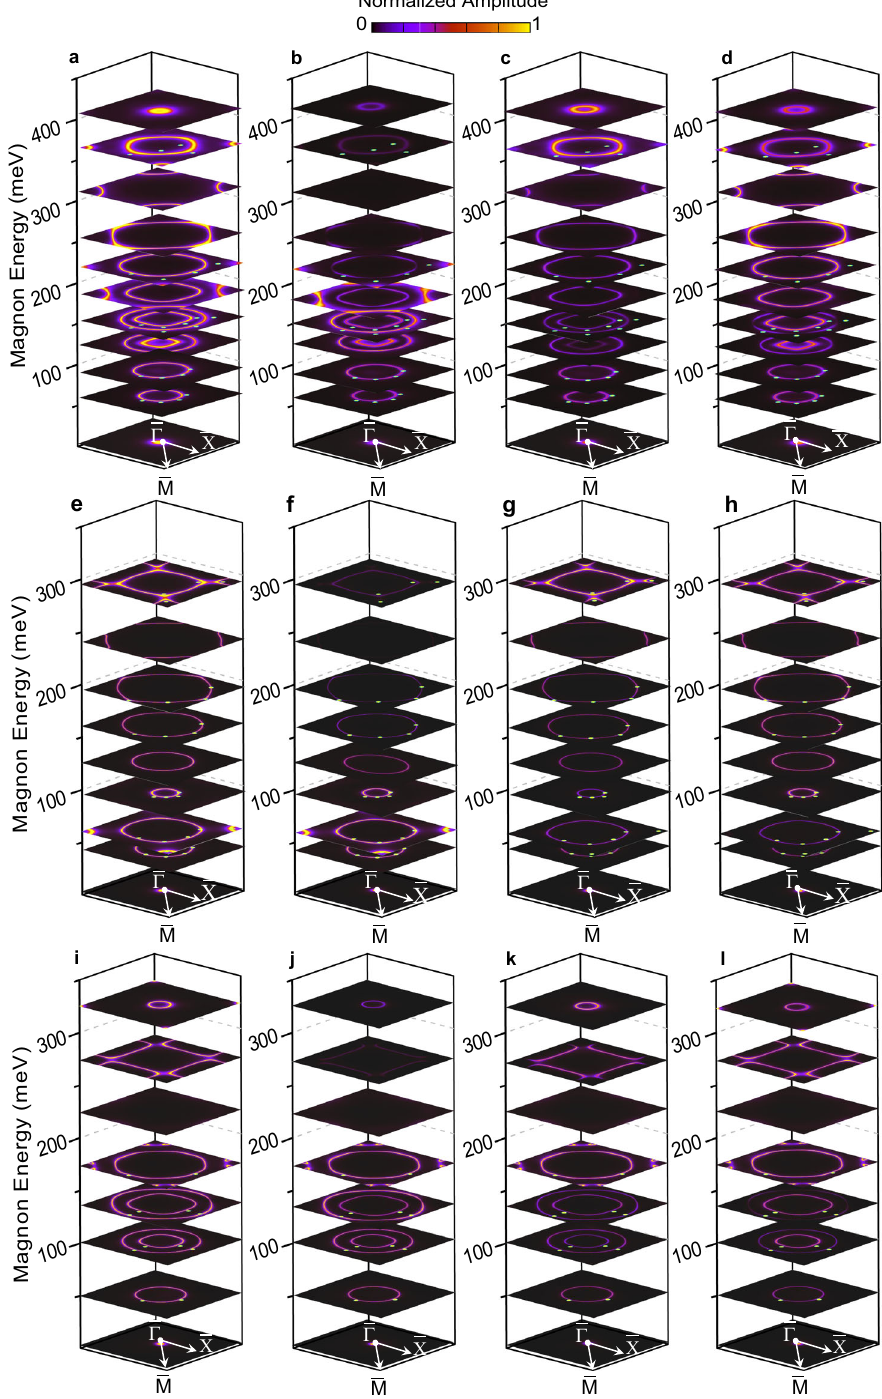
Fig. 4 Two-dimensional momentum maps at fi xed energies. Panels a – d represent the Co/Co/Co system. a The spectral function projected into all three layers, b into the interface layer, c into the middle layer, and d into the surface layer. Panels e – h represent the Co/Co/Fe system. The projected Bloch spectral function into all three layers, the interface layer, the middle layer, and the surface layer, is shown in panels ( e , f , g , h ), respectively. The results of the Co/Fe/Co system are show in panels ( i – l ), where the projected Bloch spectral function into all three layers, the interface layer, the middle layer, and the surface layer is shown in panels ( i , j , k , l ), respectively. The places where the magnon peaks are observed in the experimental spectra are shown by solid circles. In all panels, (cid:1) Γ , (cid:1) X, and (cid:1) M represent the high symmetry points of the surface Brillouin